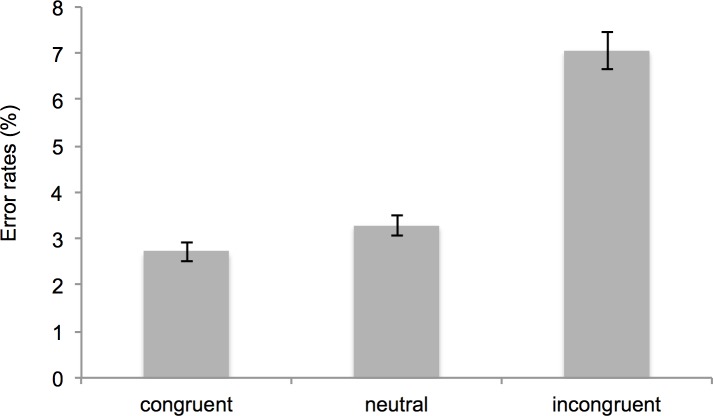
Mean error rates within the automatic imitation task separated by condition.Error bars represent standard errors of the mean.